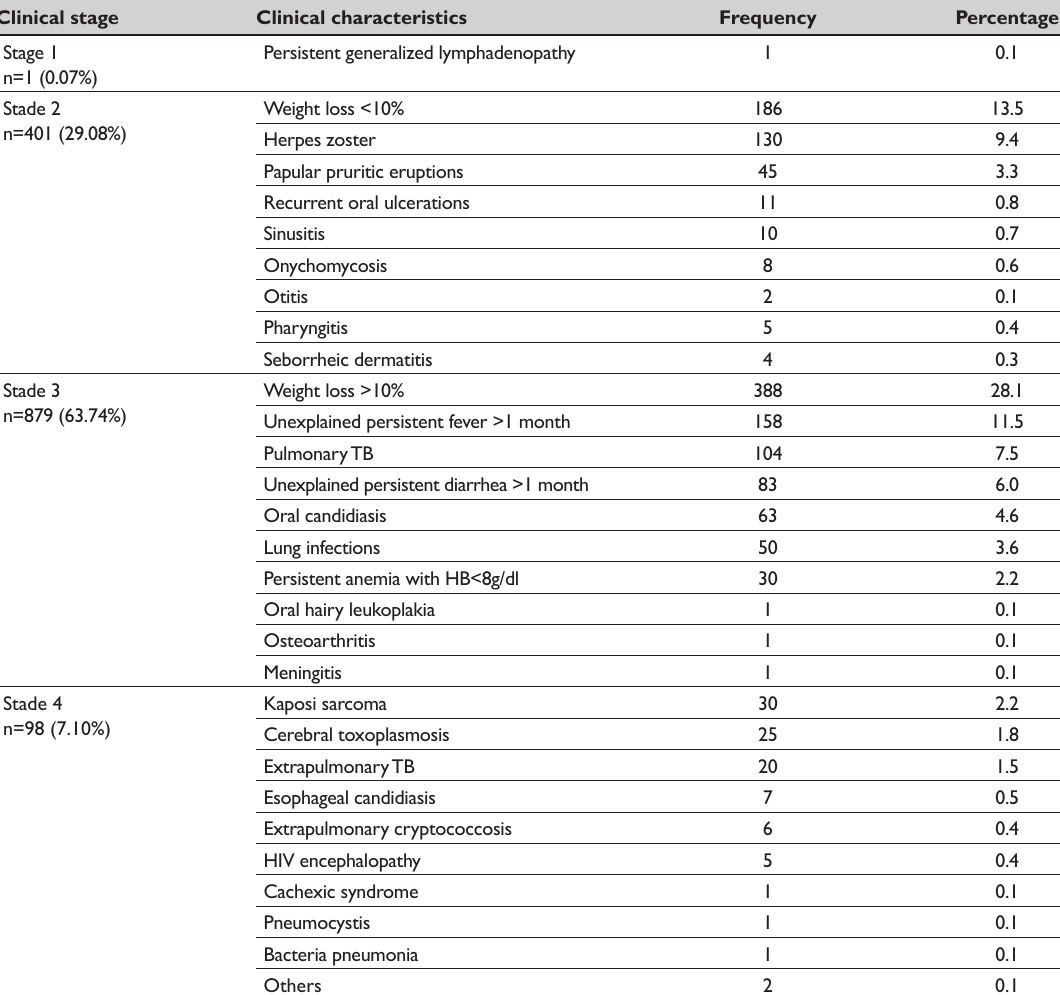
Table 6: Clinical manifestation according to the World Health Organization (WHO) staging Clinical stage Clinical